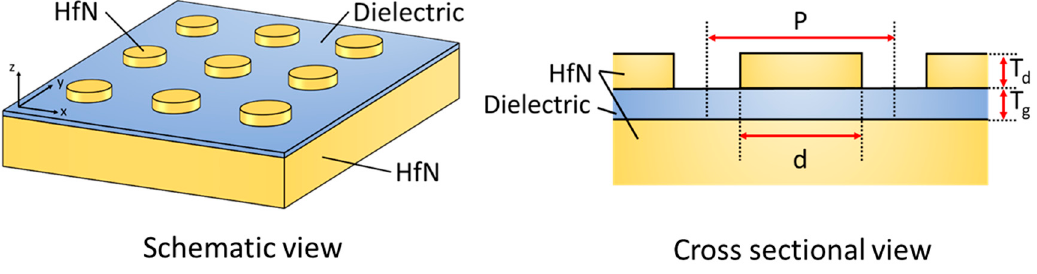
Figure 9. A schematic and cross-sectional view of a metal-dielectric-metal (MDM) metasurface based on hafnium nitride (HfN).